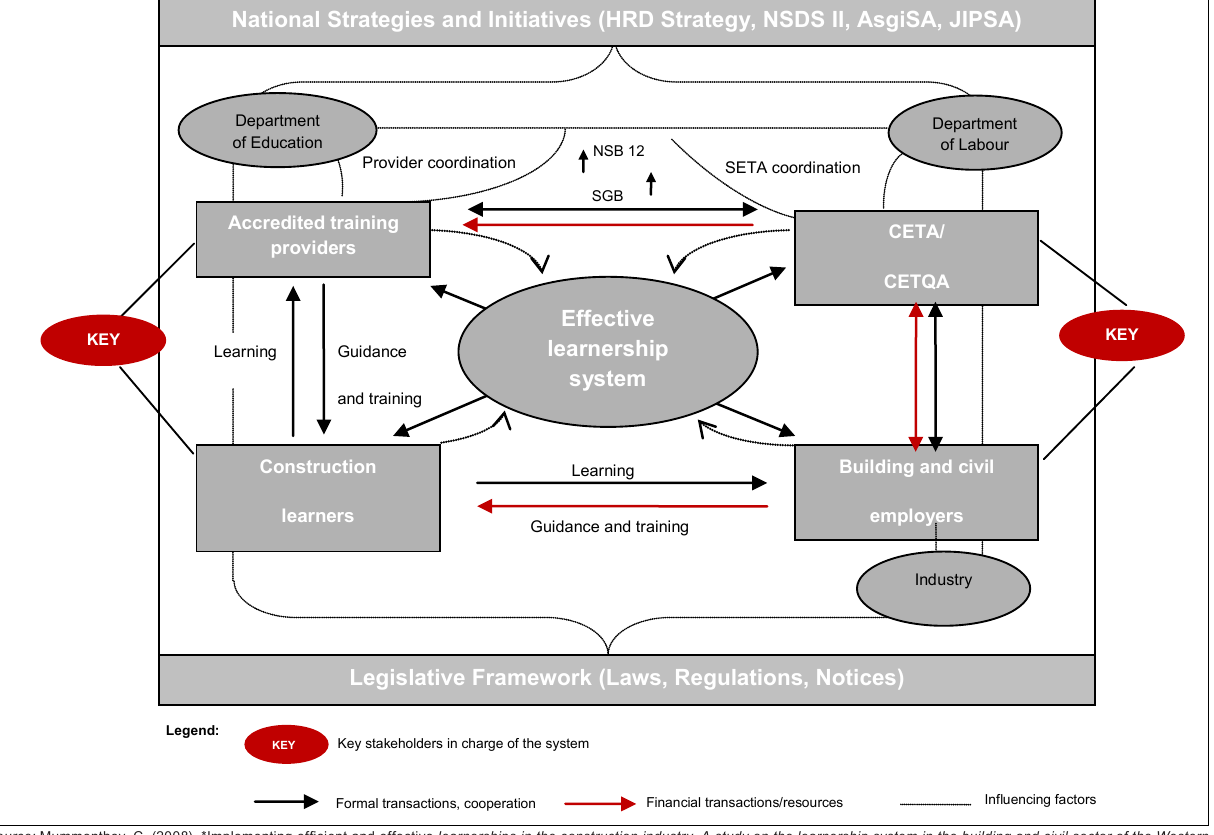
Figure 1: Learnership framework and key stakeholders (Mummenthey, 2008, p. 23) FIGURE 1 Learnership framework and key